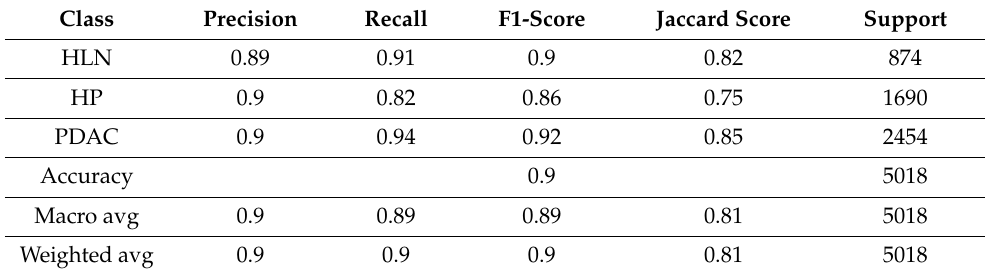
Table 1. Metrics of the uncleaned network (ResNet18): Precision, Recall, F1-Score and Jaccard score for the classes healthy pancreas (HP), healthy lymph node (HLN) and pancreatic ductal adenocarcinoma (PDAC).